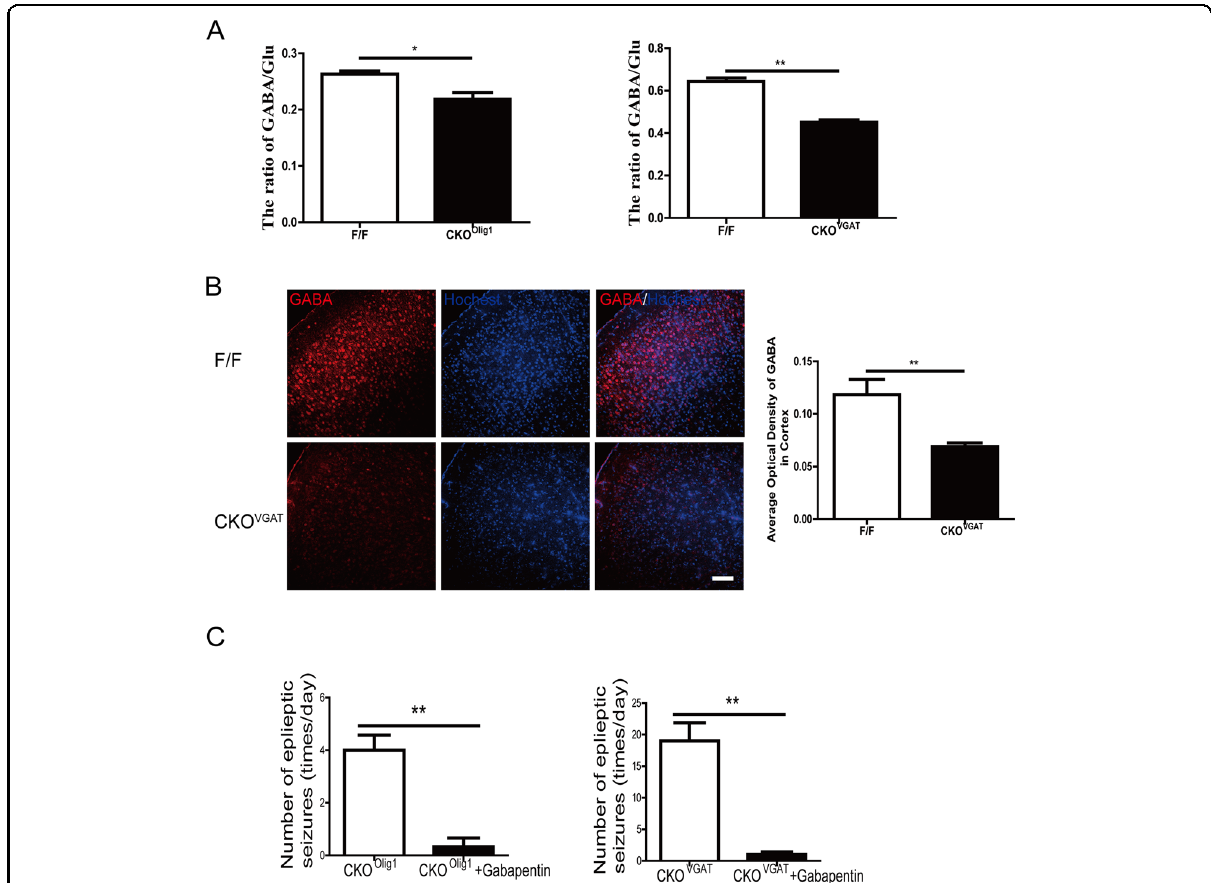
Fig. 4 Fgf 9 CKO in GABAergic neurons decreases GABA release. A The ratio of GABA/Glu in the cortex was lower in CKO Olig1 and CKO VGAT mice than in control mice. Data are mean ± SEM for 3 mice per genotype. * P < 0.05; ** P < 0.01, nonparametric Mann-Whitney test. B Confocal images of GABA in the cortex of CKO VGAT mice. Scale bars, 100 μ m. C Administration of gabapentin signi fi cantly reduced the frequency of epileptic seizures in CKO Olig1 ( n = 3) and CKO VGAT mice ( n = 4). Signi fi cant differences from the control: * P < 0.05; ** P < 0.01, paired Student ’ s t